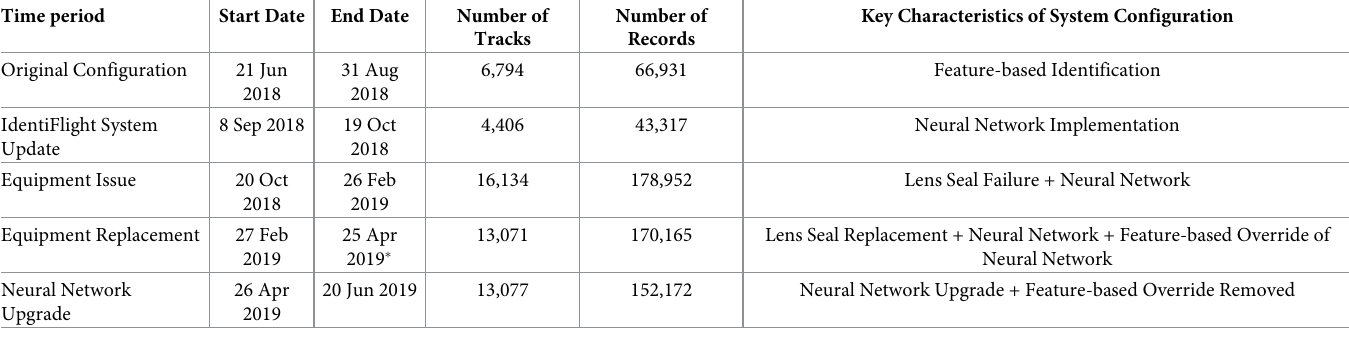
Table 1. Time periods that identified major changes to the IdentiFlight system at the Manzana Wind Power Project, California, USA from 21 June 2018 to 20 June 2019. See S2 File for detailed description of system